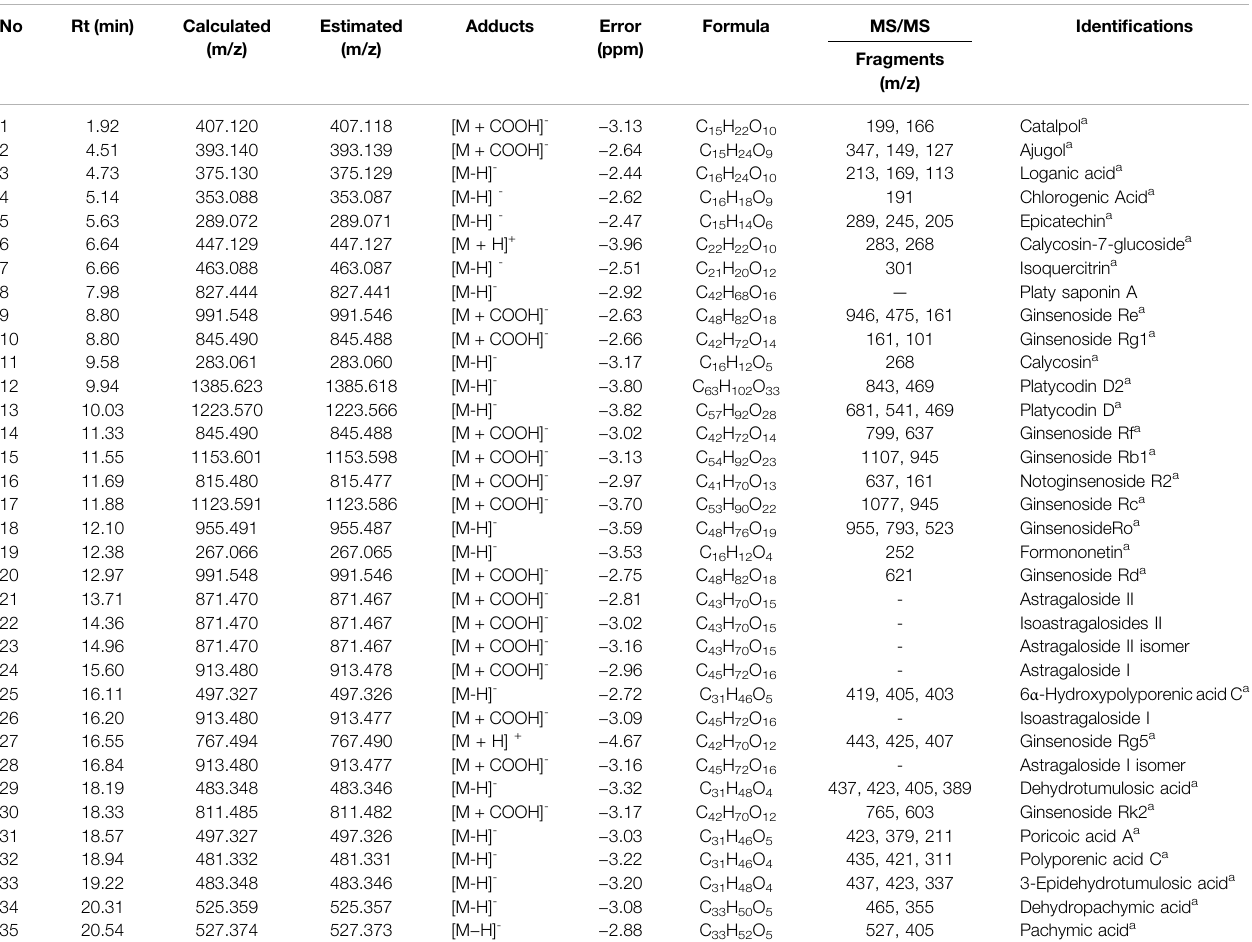
TABLE 2 | The phytochemical pro fi le of OCD20015-V009 by